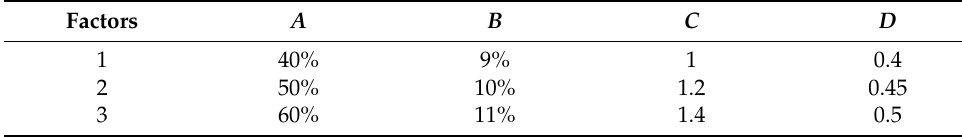
Table 4. Impact factors and levels in RSM.